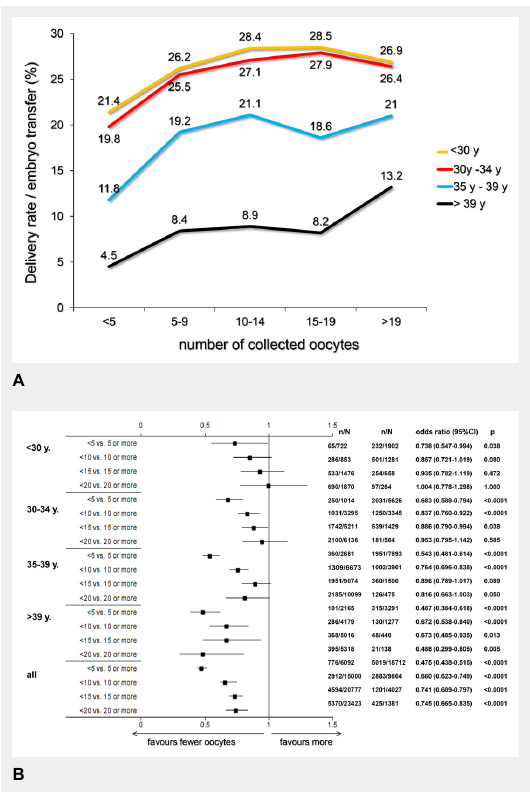
A The yearly delivery rates per embryo transfer (in %) achieved with ART from 2005 to 2012 were computed in relation to the number of collected oocytes and to the age of the infertile women during the treatment. The outcome of ART strongly depends on the age of the treated patient and to a lesser extent on the number of collected oocytes. B Delivery rates and their relationship with the number of collected oocytes and the age of the treated infertile women at oocyte collection, using the pooled FIVNAT-CH data collected between 2005 and 2012. Among all treated patients the delivery rates per embryo transfer significantly depended on the quantity of retrieved oocytes (p <0.0001), but this dependence was less pronounced among younger patients. In each age category the number of deliveries was significantly lower if fewer than five oocytes were retrieved. In all age categories (except those older than 39 years) the delivery rates were not further improved if more than 15 oocytes were